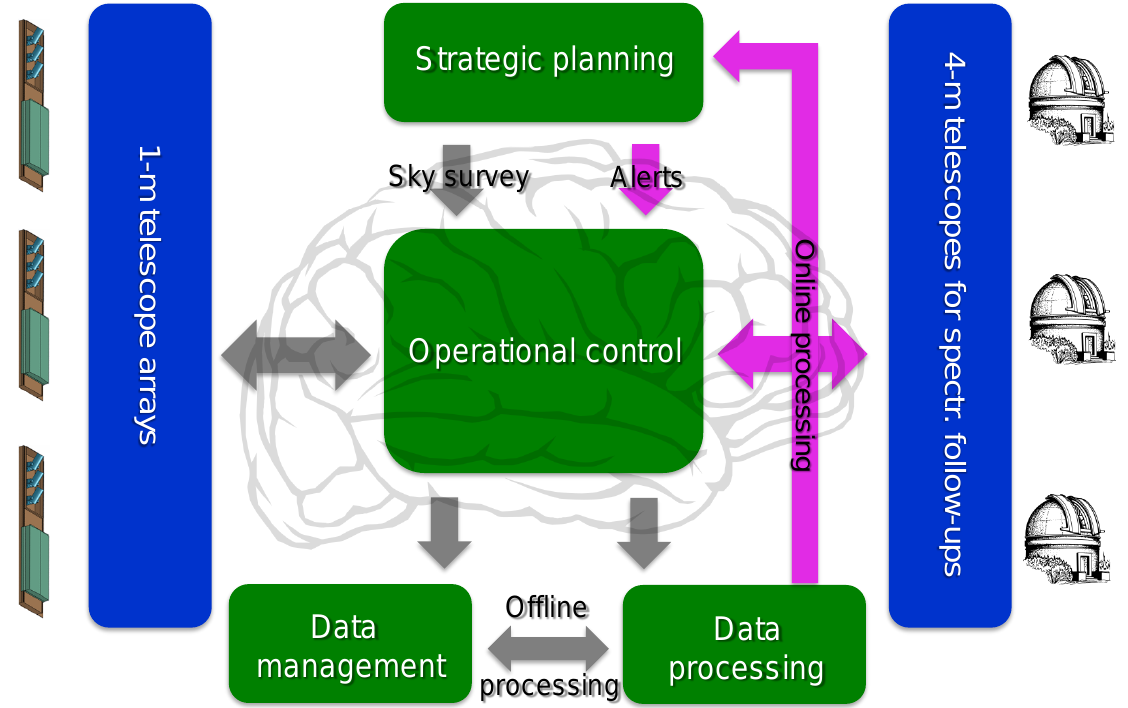
Figure 1. Structure of the SiTian project, with the connections between its main elements: the monitoring array, the spectroscopic follow-up telescopes, and the data processing/management